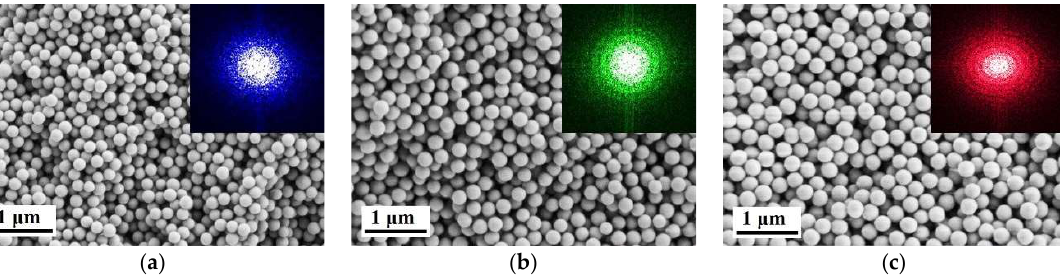
Figure 2. SEM morphology of the APSs, the diameter of HDTMS-SiO 2 nanospheres were 220 nm, 270 nm, and 300 nm, respectively; inset are the Two-dimensional Fourier Transform of the SEM images.